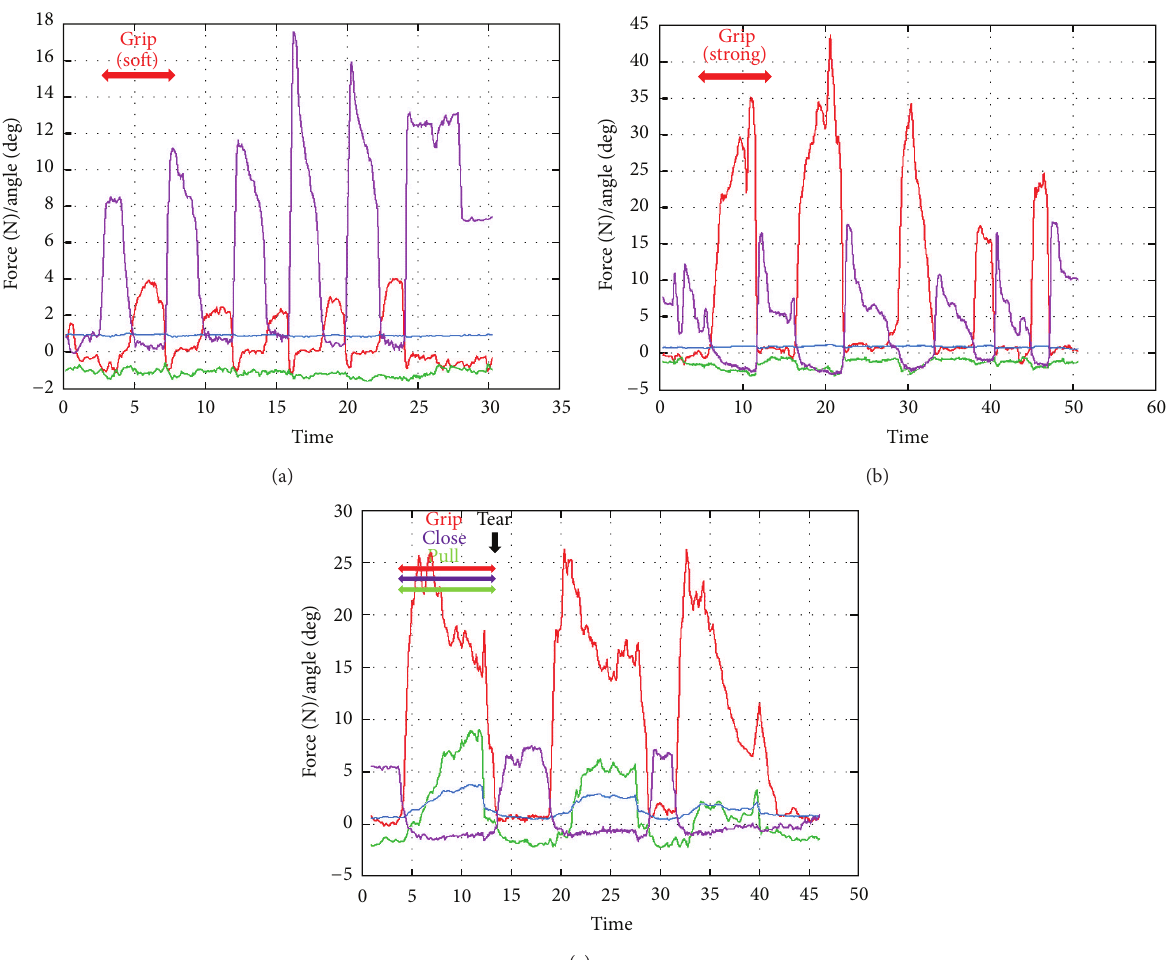
Figure 11: Experiment (F), grip liver softly; (G) grip the liver strongly; (H) grip and pull on the